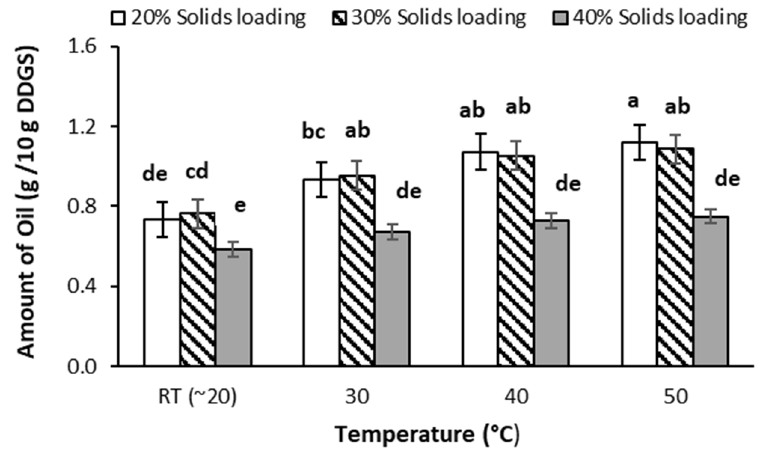
Figure 1. Effects of temperature and solids loadings on the amount of oil recovered from the original DDGS. Letters a–e refer to the significant difference from each other.